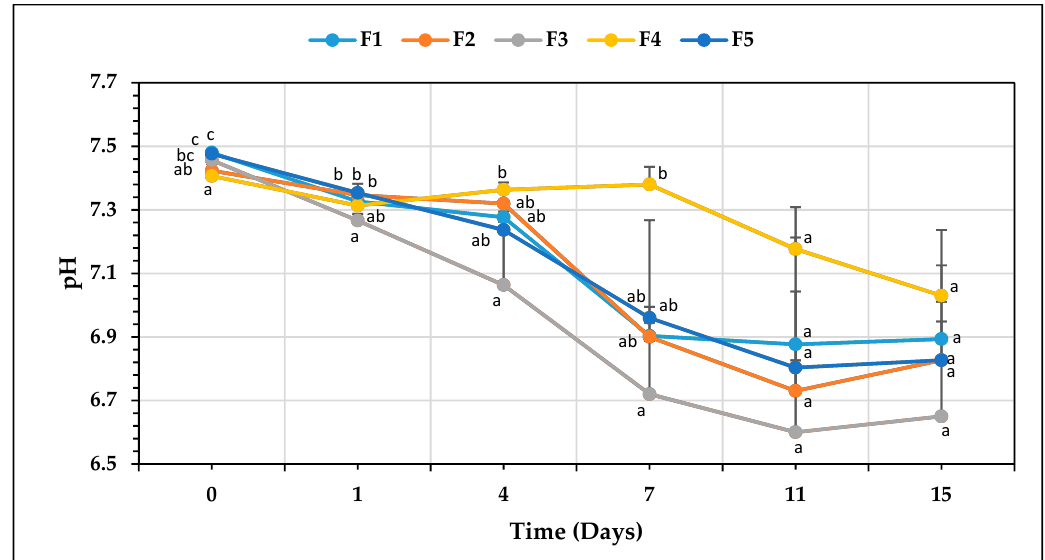
Figure 6. Study of the solution pH vs. immersion time in simulated biological fluid (FBS) of the films. Formulations: F1 (CS:PVA:ox-CNO 30:70:0); F2 (CS:PVA:ox-CNO 29.75:70:0.25); F3 (CS:PVA:ox-CNO 29.50:70:0.50); F4 (CS:PVA:ox-CNO 29.25:70:0.75); F5 (CS:PVA:ox-CNO 29.00:70:1.00). Different superscript letters indicate significant differences between treatments ( p > 0.05).